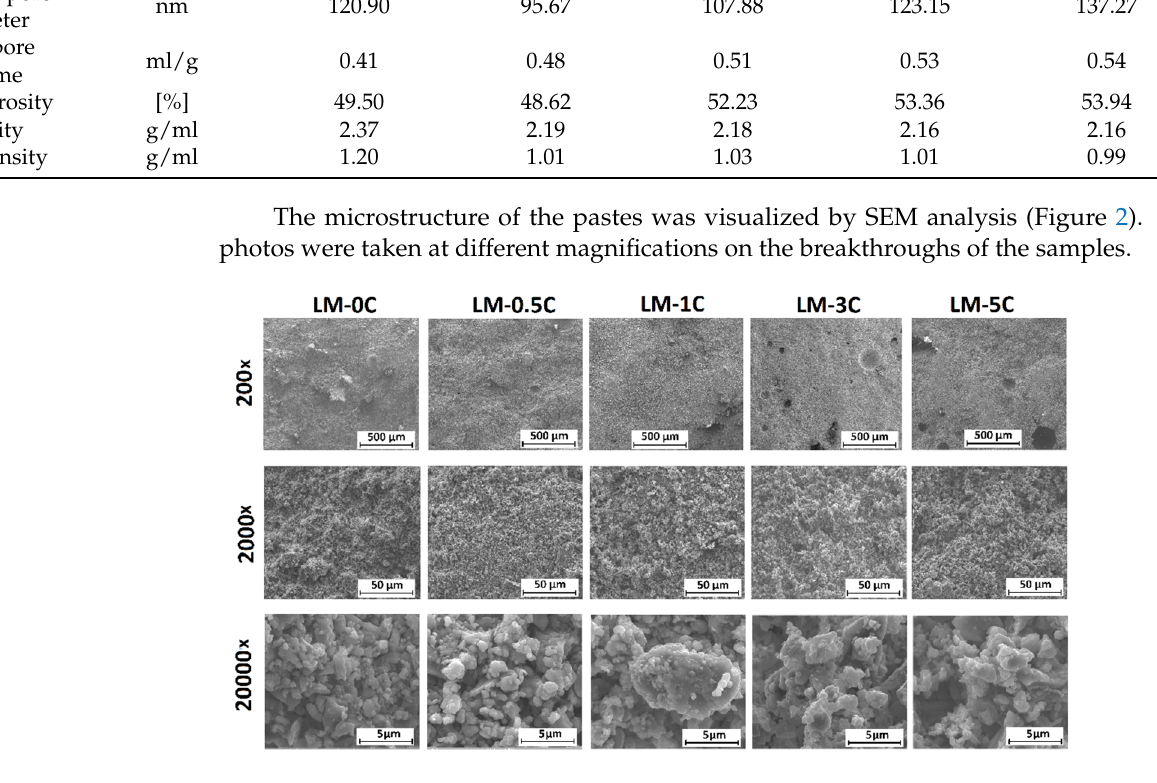
Figure 2. SEM images of paste samples.